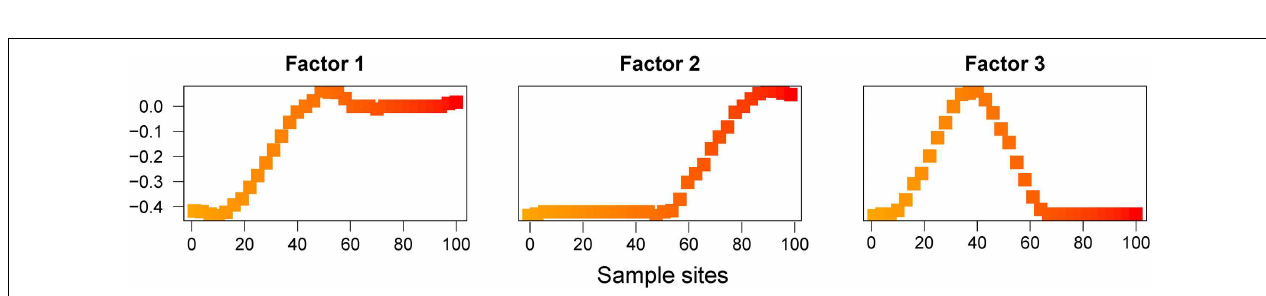
FIGURE 3 | SFA factor maps for data simulated under an IBD model. Plots of the first three Factor maps for SFA.